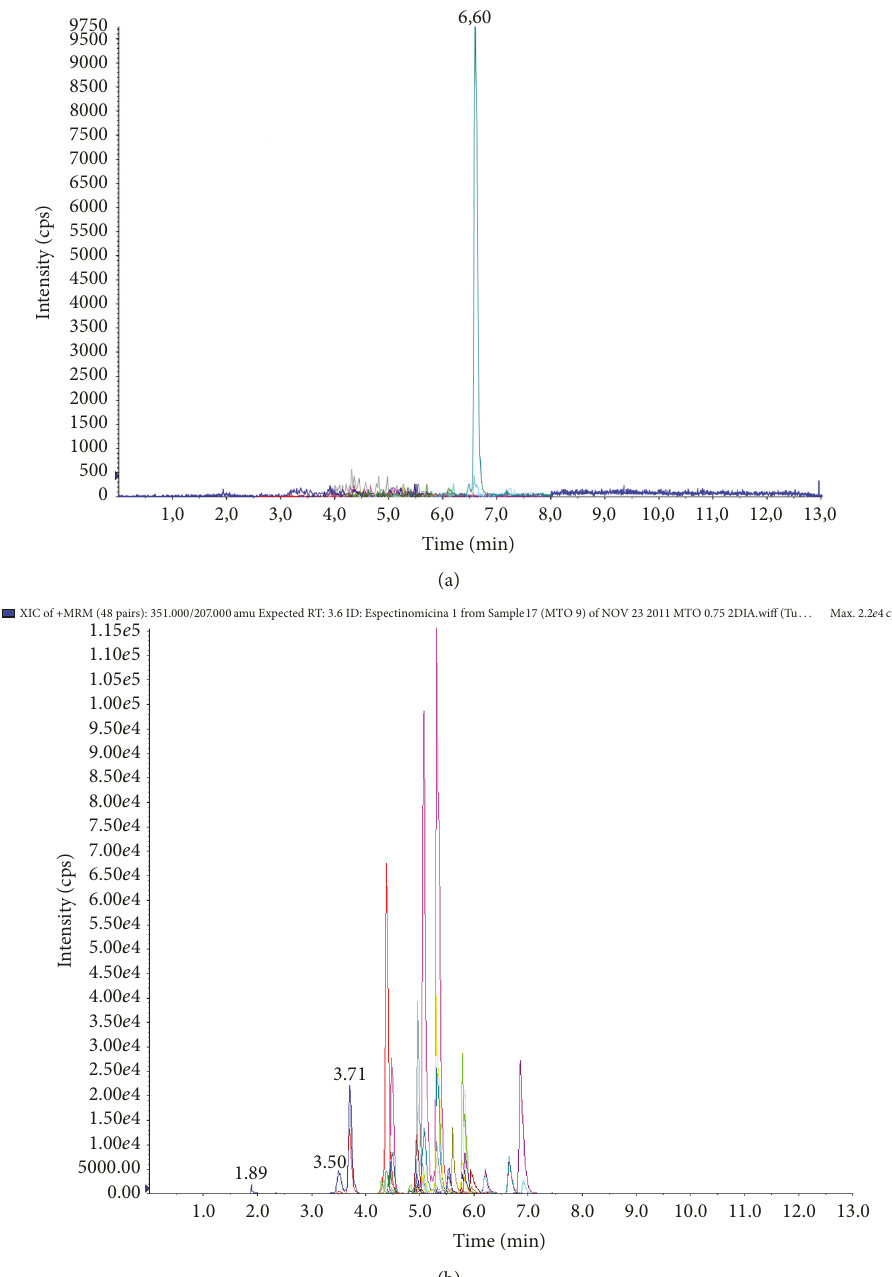
Figure1:Chromatogramofamethodblank-extractionwith5%trichloroaceticacid,withouttheadditionoftheeggmatrix(a),todemonstrate the presence of an interferent compound from the TCA 5% solution and chromatogram of the egg matrix with the addition of the standard solutions of tetracyclines, aminoglycosides, quinolones, and lincosamides at the 0.75 MRL level